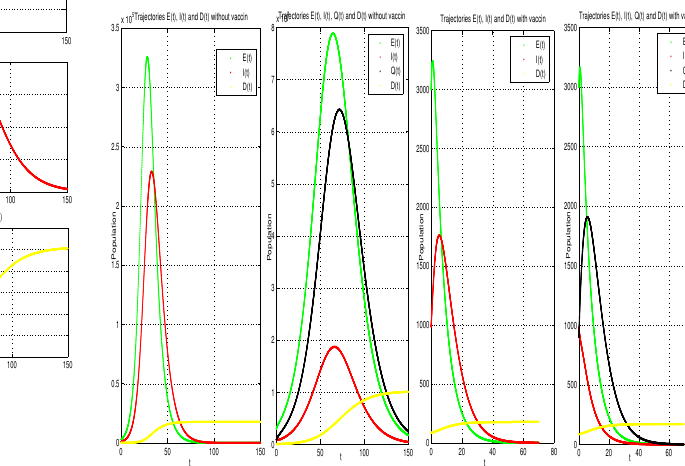
Figure 8. Numerical